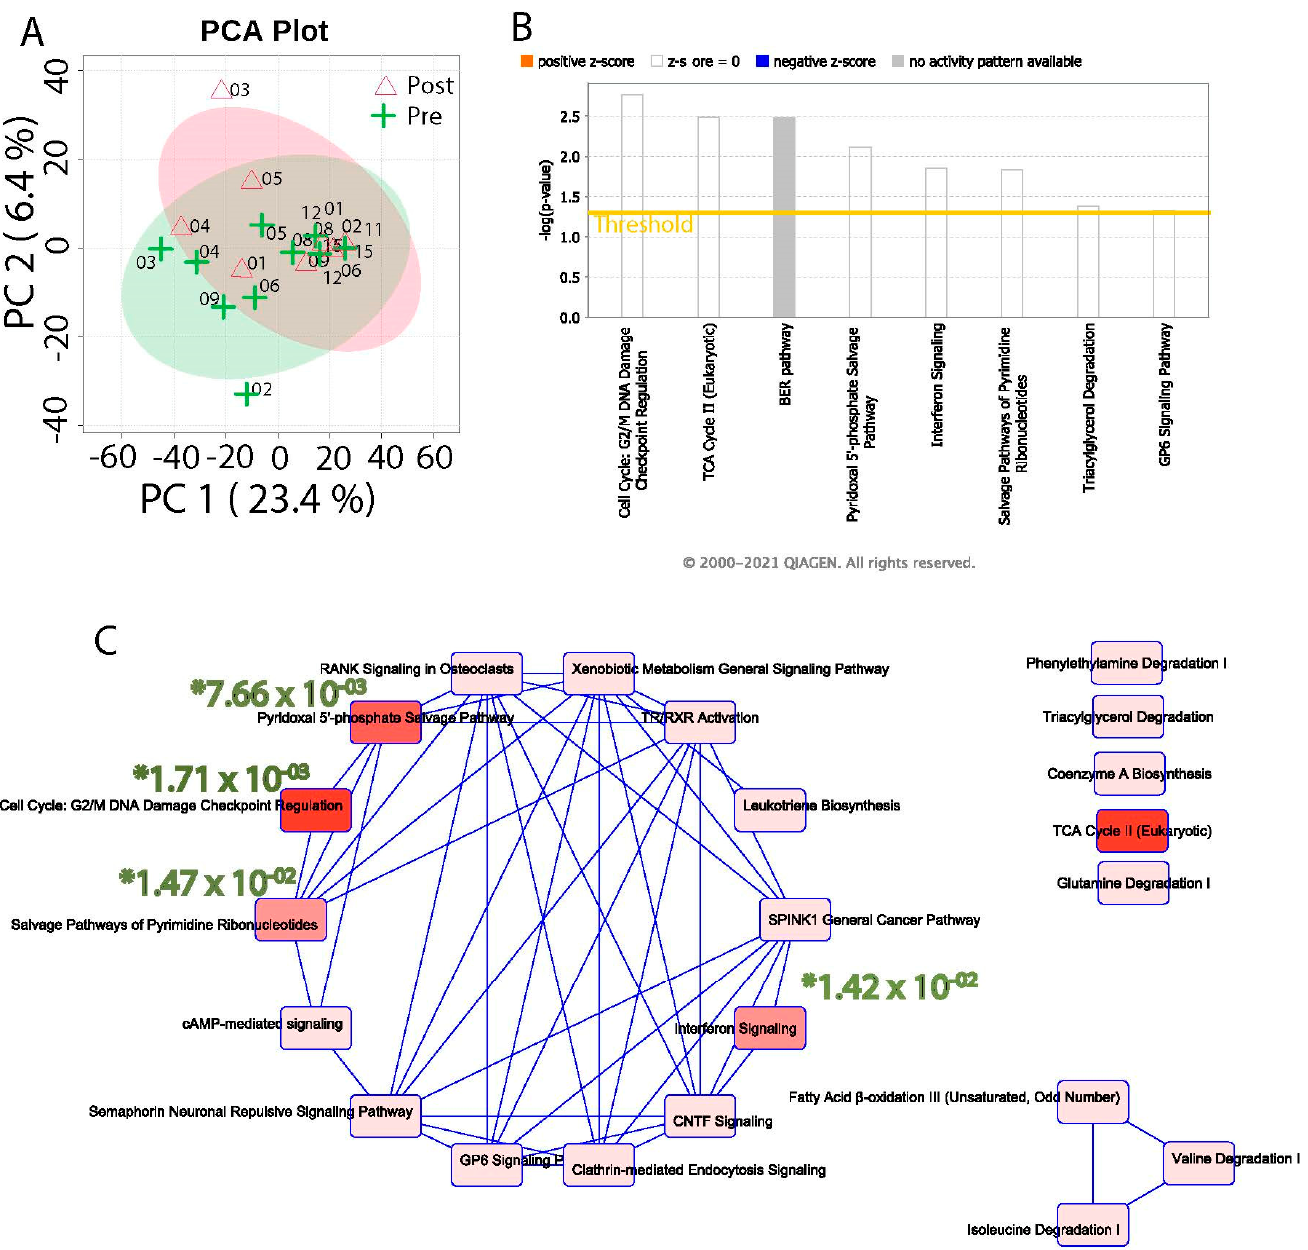
Figure 1. ( A ) PCA plot for pre- and post-surgery conditions. ( B ) IPA pathway enrichment showing top eight pathways for 1116 significant genes. The yellow line represents the threshold of p -value ≤ 0.05. ( C ) Their network of interaction of topmost pathways is shown. ( C ) Overlapping pathways: The figure shows overlapping pathways associated with differential genes. The nodes represent pathways and edges are labeled with the number of common genes connecting each node. The four most statistically significant pathways are marked with a * followed by the significant p